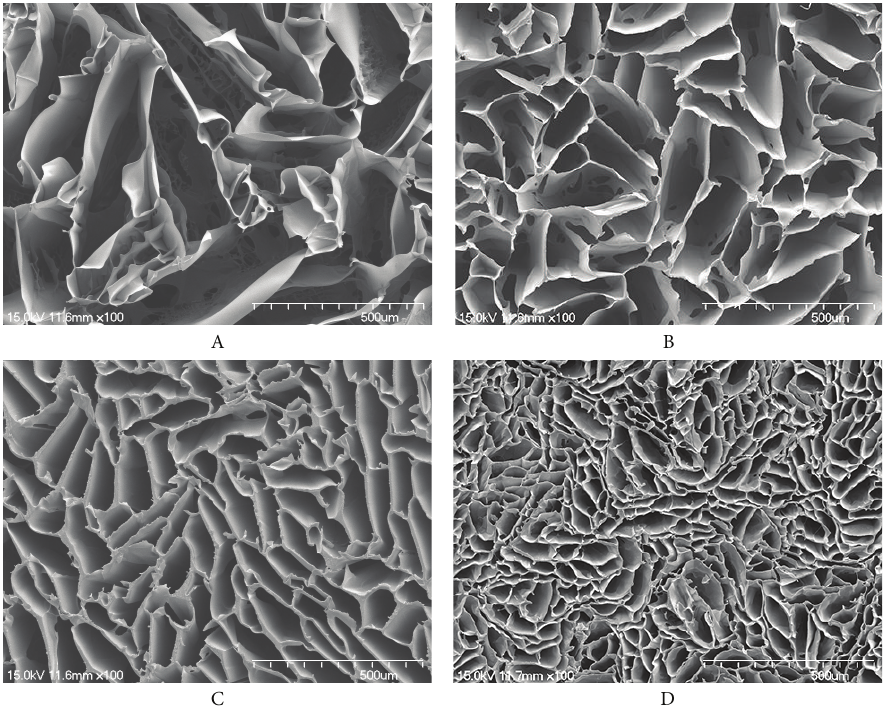
Figure 1: SEM images of different scaffolds’ cross sections (scale bar: 500 𝜇 m).